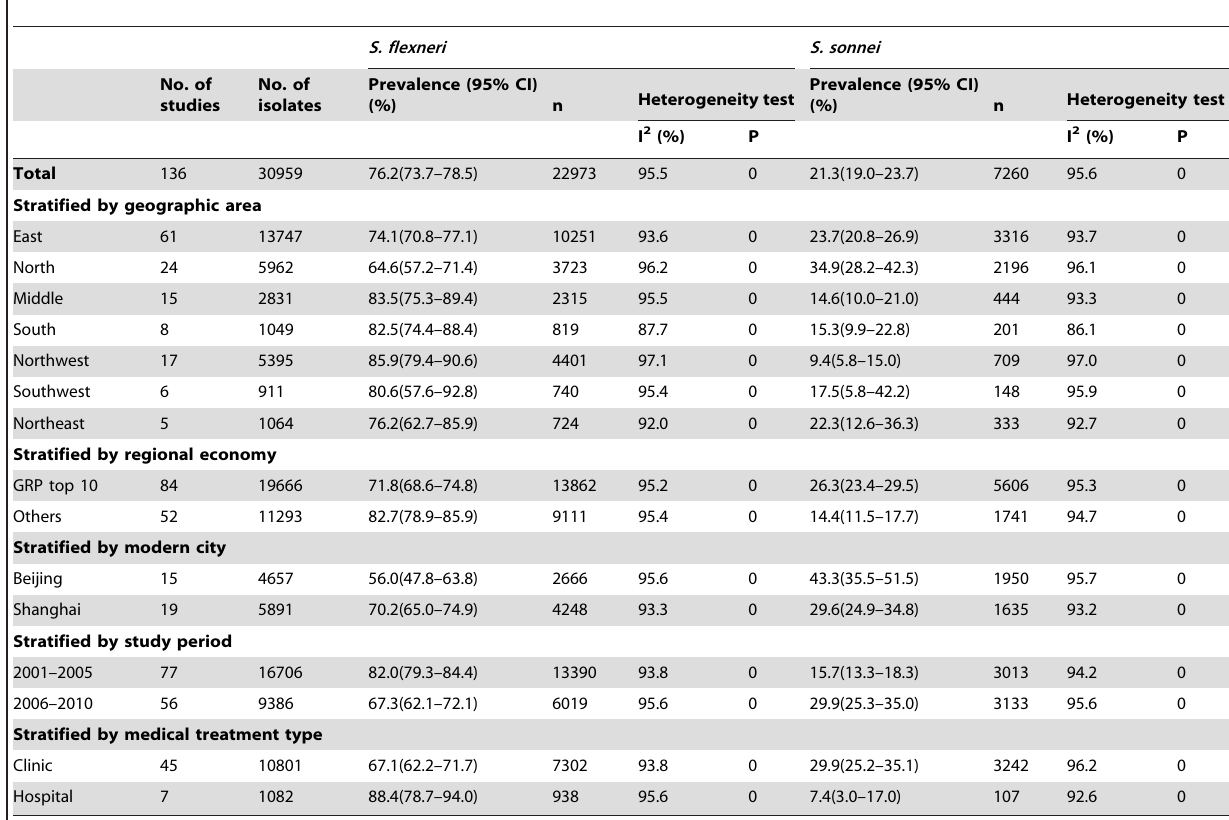
Table 1. Prevalence of causative species of shigellosis in mainland China,